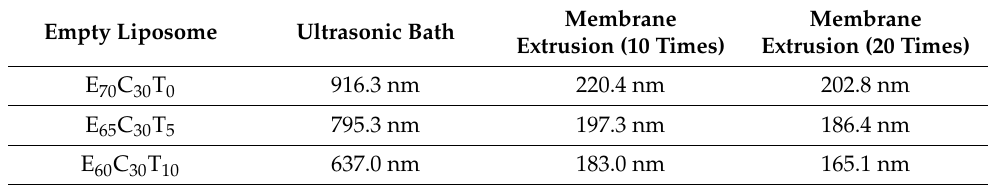
Table 4. Comparison of particle size of liposomes obtained by different